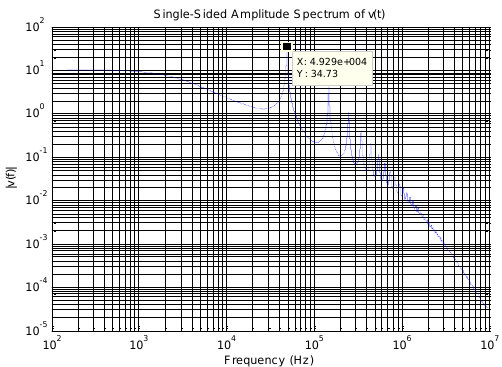
Fig. 31. Frequency response characteristics of the power transformer.